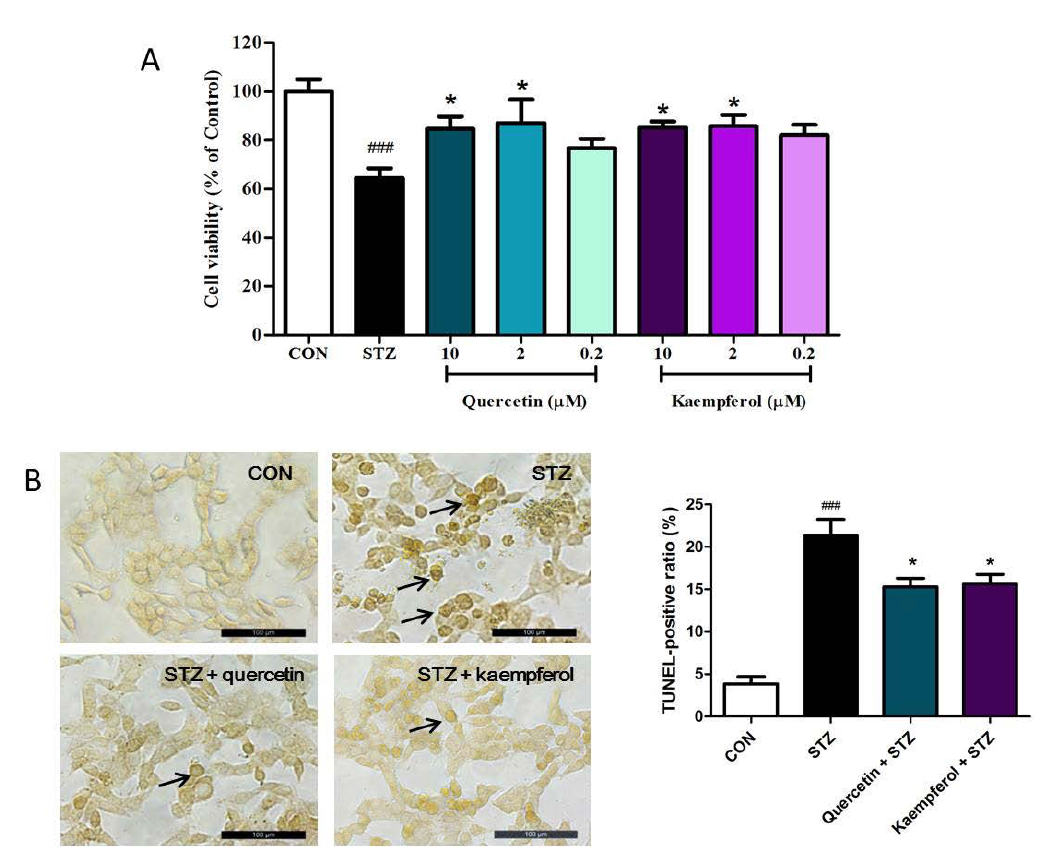
Figure 4: The effects of kaempferol and quercetin on STZ-induced apoptosis on NIT-1 cells. (A) NIT-1 cells were preincubated with kaempferol and quercetin (0.2, 2, 10 μM) for 2 h formerly 32 mM STZ treated for 24 h. Cell viability was measured by using MTT method; (B) NIT-1 cells were preincubated with kaempferol and quercetin (10 μM) for 2 h formerly 32 mM STZ treated for 24 h, After staining with 50 μL TUNEL reaction mixture, TUNEL-positive cells were analyzed. Data are expressed as the mean ± SEM (n = 3). ### P < 0.001, compared with the control group; ∗ P < 0.05, compared with the STZ-treated